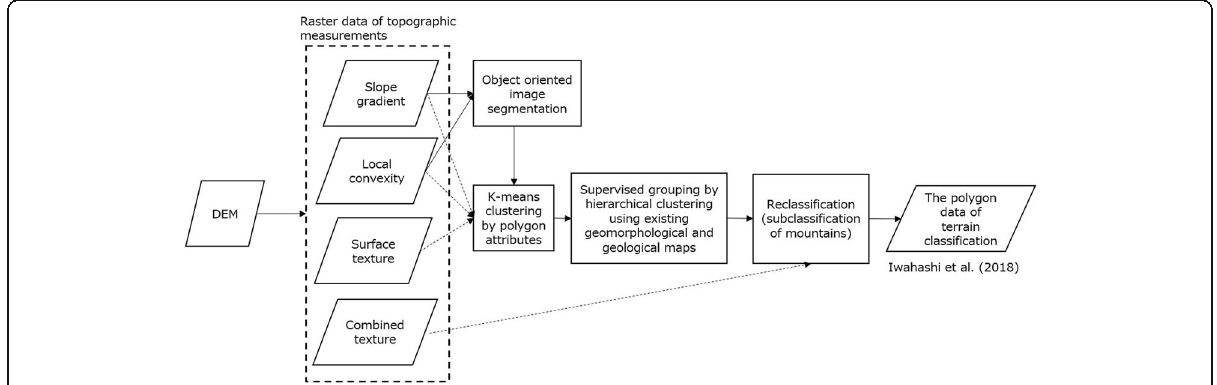
Fig. 2 Outline of the classification method of Iwahashi et al.